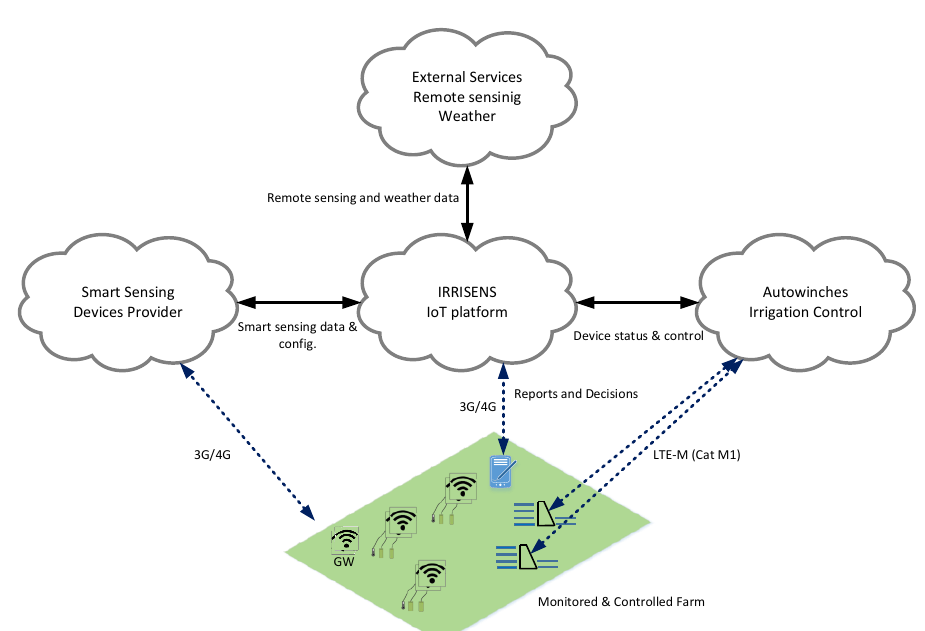
Figure 1. Schematic diagram representing the interaction between the IoT platform presented in this study (IRRISENS) and the external services.